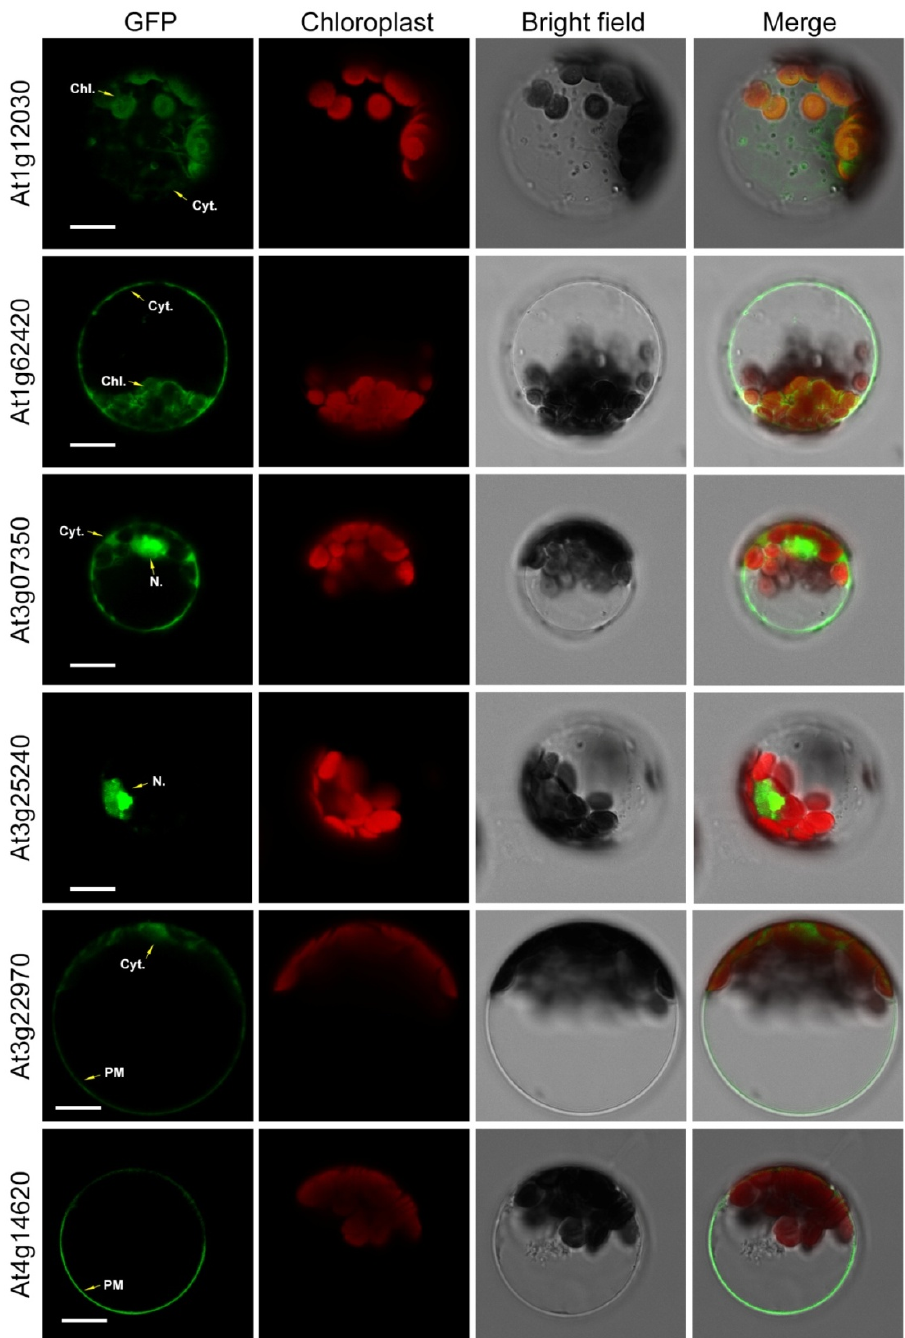
Figure 4. Subcellular localization of Arabidopsis DUF506 proteins visualized by transient expression of GFP fusion constructs in Arabidopsis mesophyll protoplasts. Chl., chloroplast; Cyt., cytoplasm; N., nucleus; PM, plasma membrane. Scale bar, 10 µm.